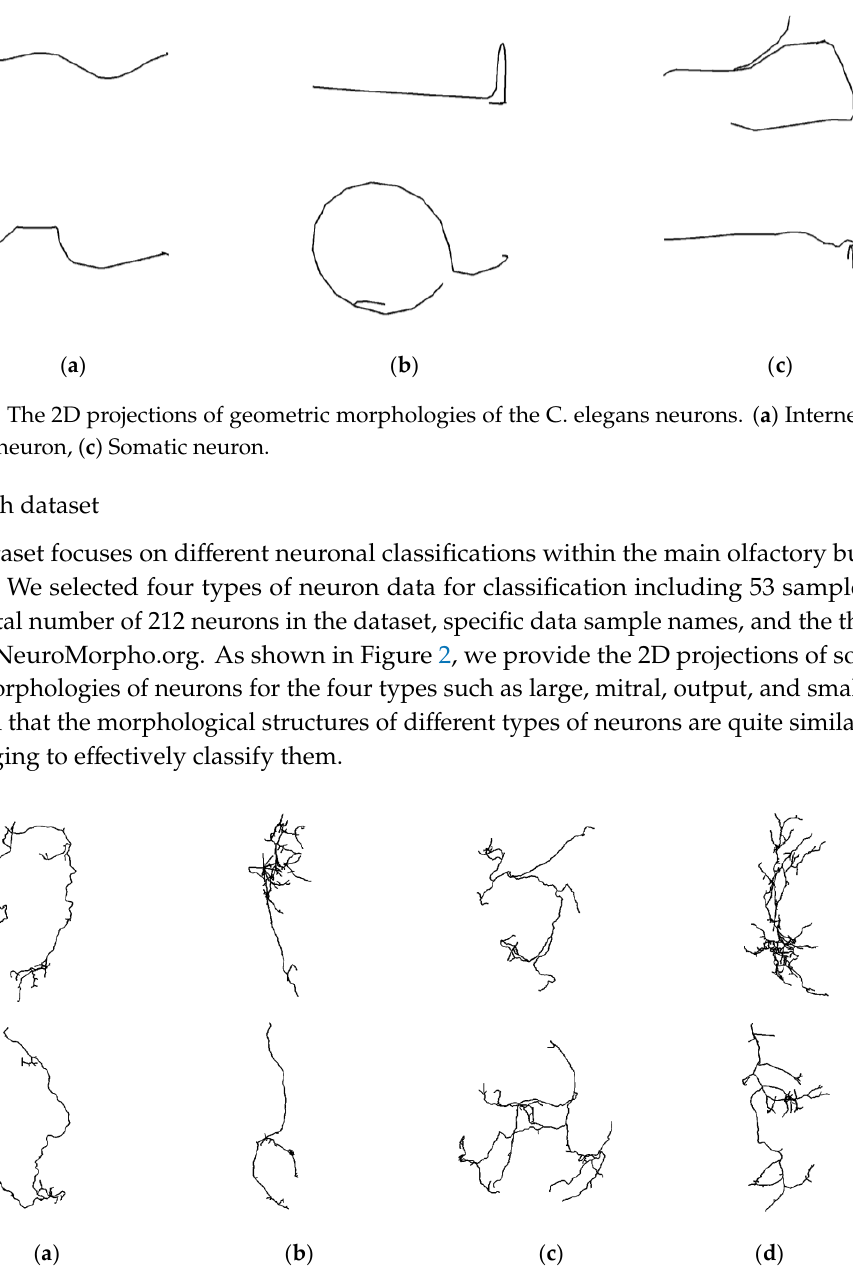
Figure 2. The 2D projections of geometric morphologies of the zebrafish neurons. ( a ) Large, ( b ) Mitral, ( c ) Output, ( d ) Small.